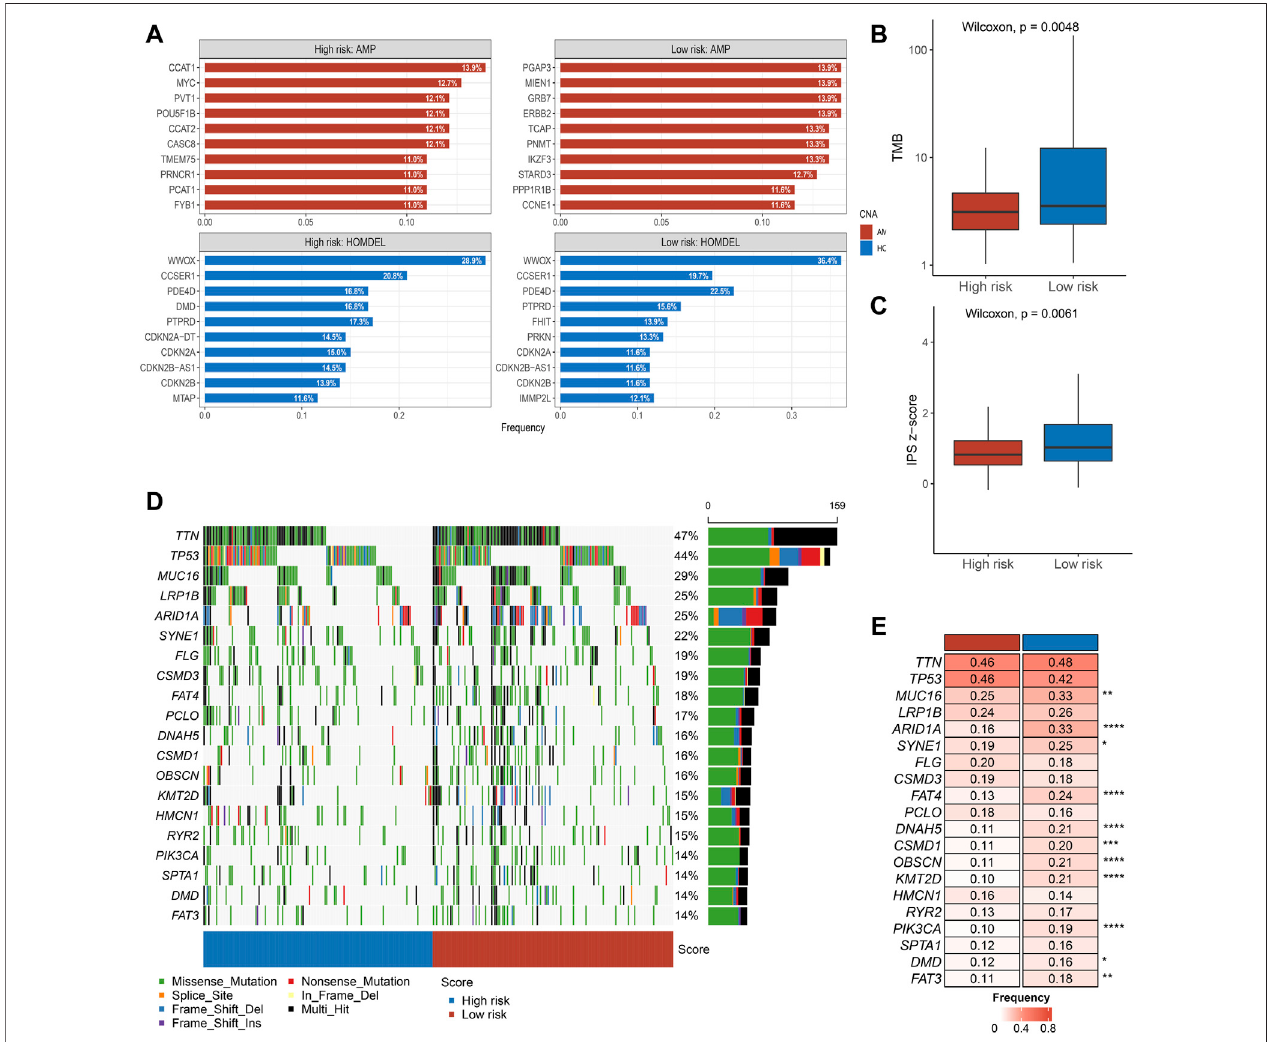
FIGURE 4 | Multi-omics alteration of the PLPPS model (A – C) . The differences in CNV (A) , TMB (B) , and IPS (C) between the two groups. (D) . Waterfall plot of 20 frequently segments in the two subtypes (E) . Comparison of mutation frequency of top 20 segments.